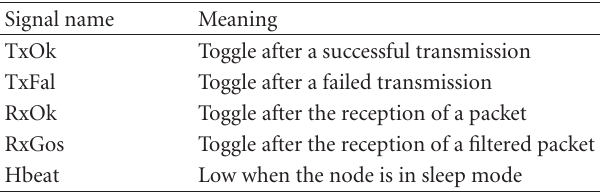
Table 1: Signal meaning